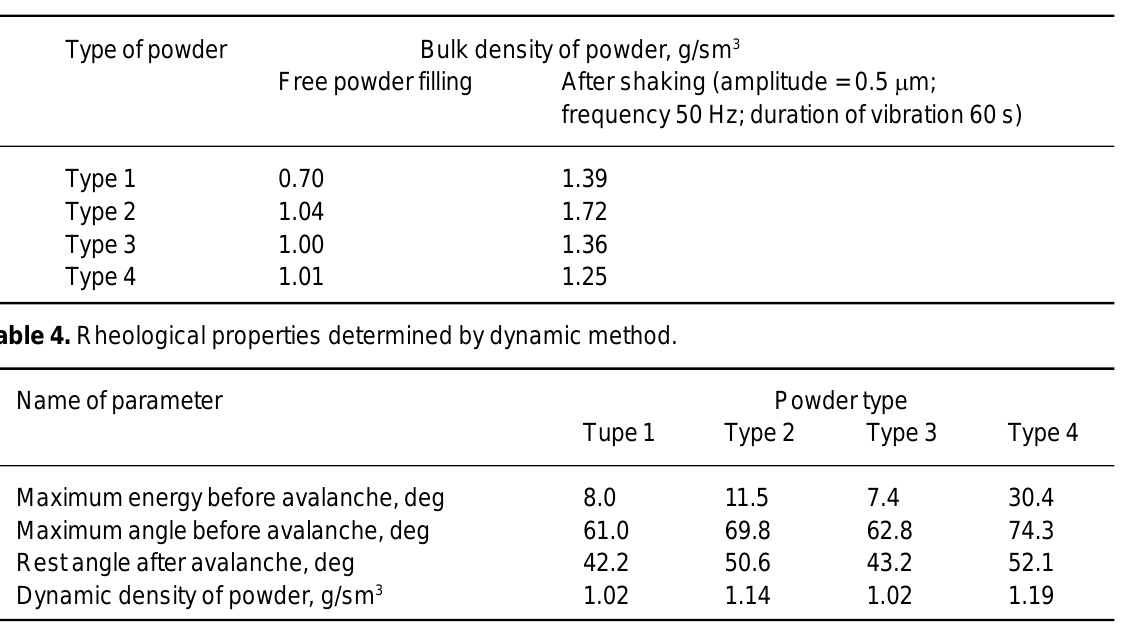
Table 3. Rheological properties of powders determined by static method.